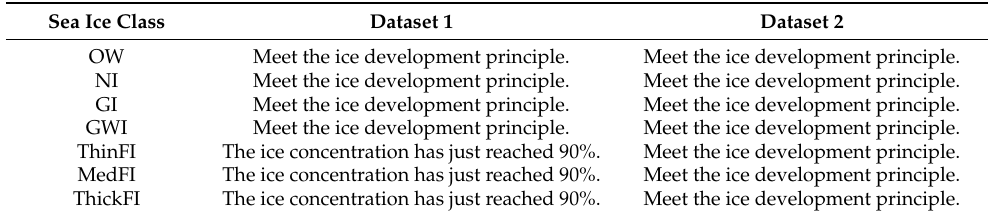
Table 8. Description of two datasets.